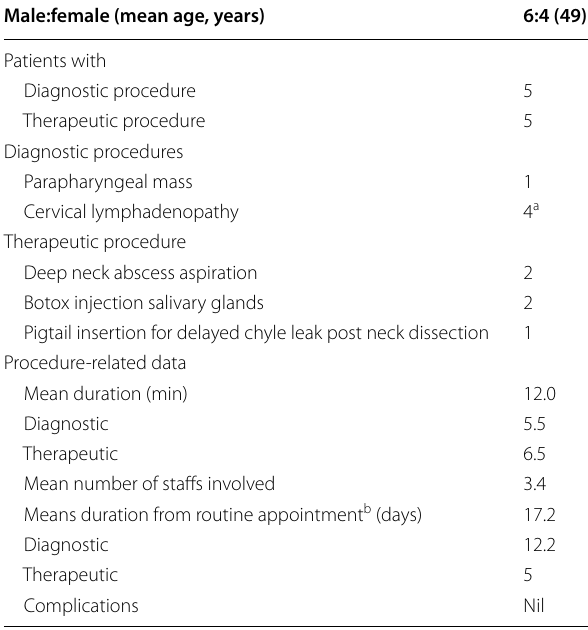
Table 1 Patient characteristics and procedures